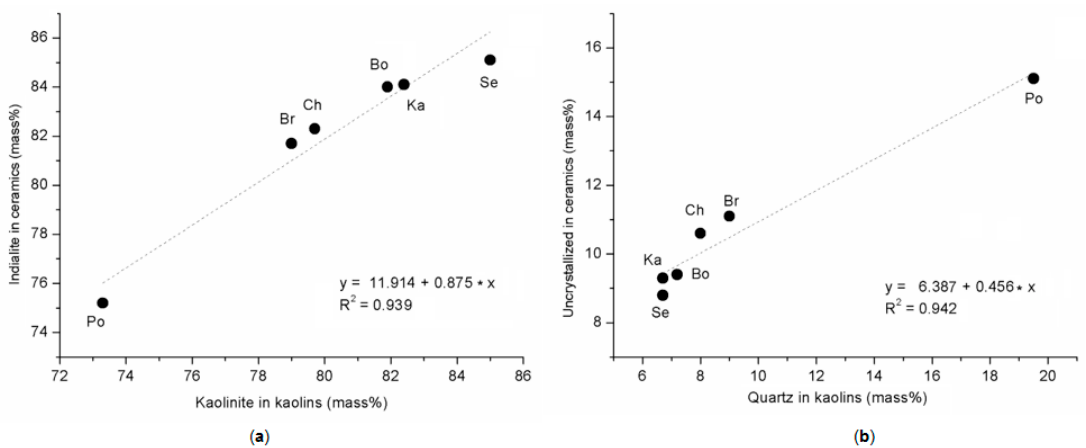
Figure 6. Content of mineral phases in ceramic samples in relation with minerals in kaolins: ( a ) indialite vs. amount of kaolinite and ( b ) non-crystalline phases vs. quartz.